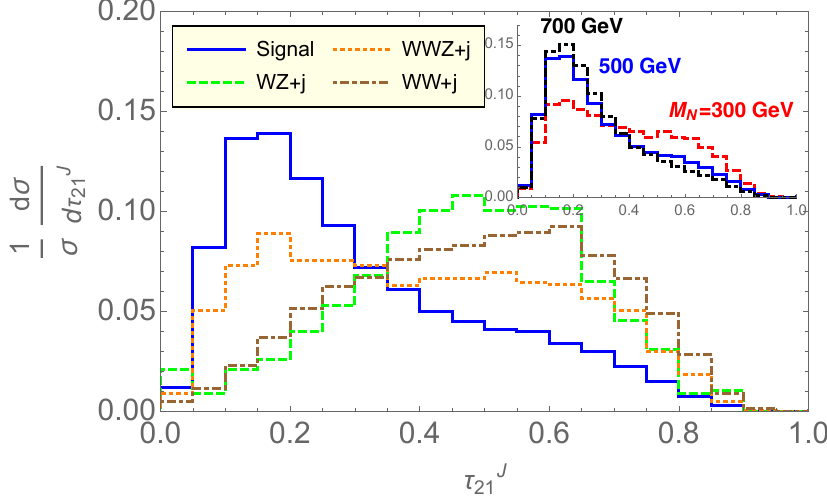
Figure 6 . Normalised di(cid:11)erential distributions as a function of two to one N-subjet ratio (cid:28) J fat-jet (J) in case of same sign di-lepton + fat-jet production channel after the application of the basic selection cuts including p J > 100 GeV. Distributions of one signal region with all dominant T backgrounds are shown in the plot. Inset shows the variation for three benchmark signal points with M N = 300 ; 500 and 700